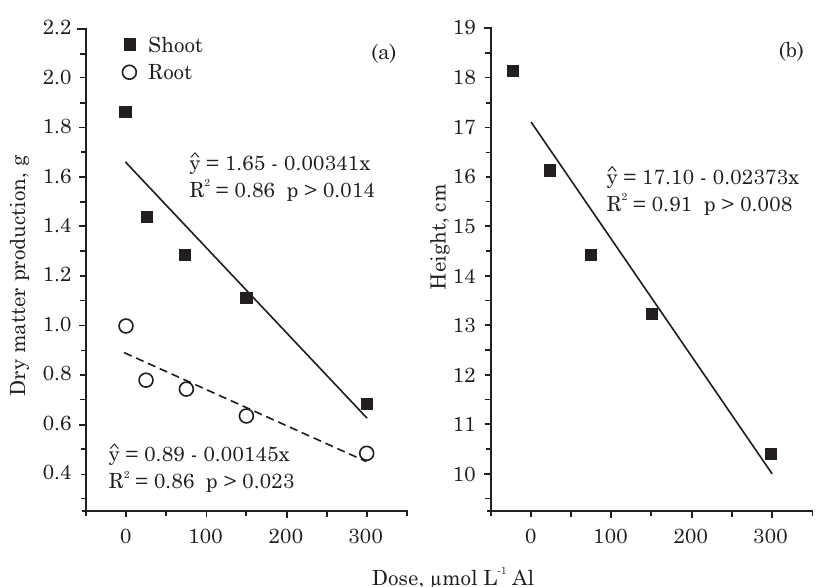
Figure 1. a) Shoot and root dry matter production and b) height of corn plants exposed to different Al concentrations during the experimental period of 21